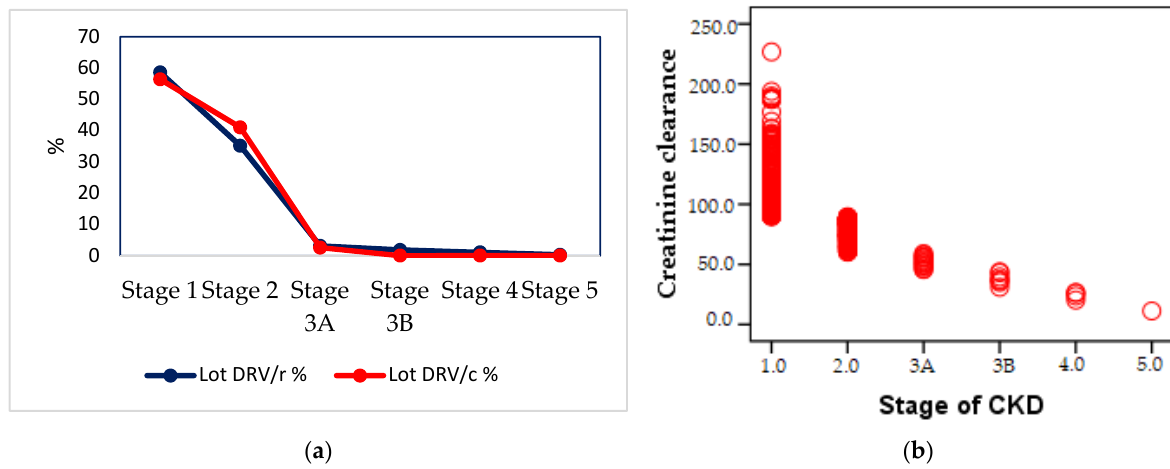
Figure 8. ( a ) Percentage distribution of renal impairment in the population of groups, ( b ) Pearson correlation between the value of renal clearance and the impairment of renal function.